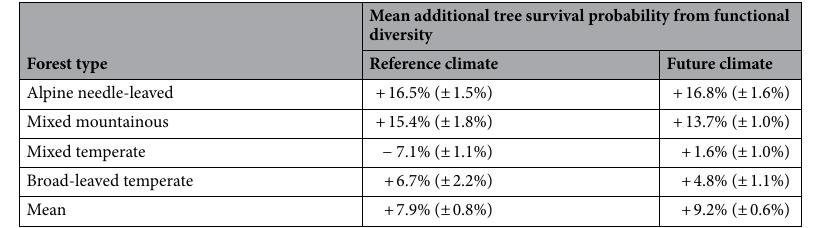
Table 1. Additional survival probabilities for trees in each forest site under reference climate (central column) and future climate (RCP4.5, right column) in case FR and FDv are high, while FE is low. Survival odds from partial dependence plots were extracted for high FR, high FDv and low FE (upper and lower 10%-percentiles) separately and summed up based on Supplementary Table S3. Values in brackets correspond to error propagated standard deviations from Supplementary Table